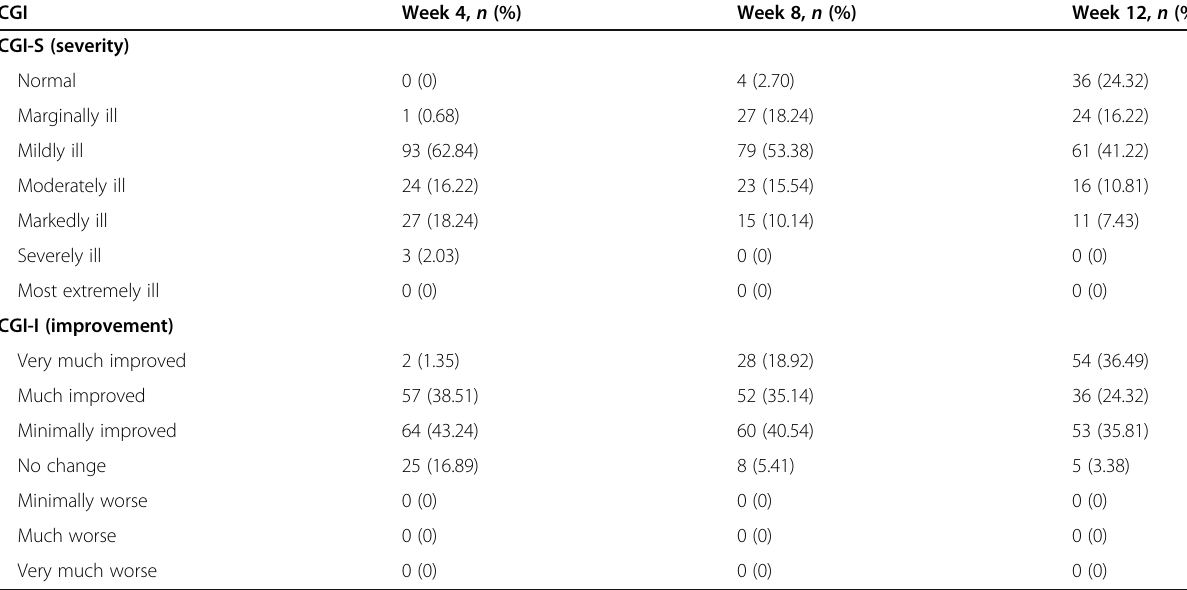
Table 2 Changes of clinical global impression during escitalopram therapy ( N = 148*) CGI Week 4, n (%) CGI-S (severity)